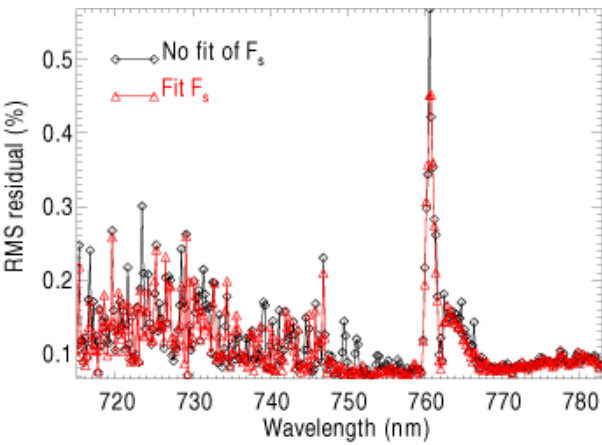
Fig. 14. RMS of GOME-2 radiance residuals obtained with and without fitting F s (in percent of the observed radiance) for a sin- gle day for moderately to highly vegetated ) is fitted/retrieved and when it is not fit- s